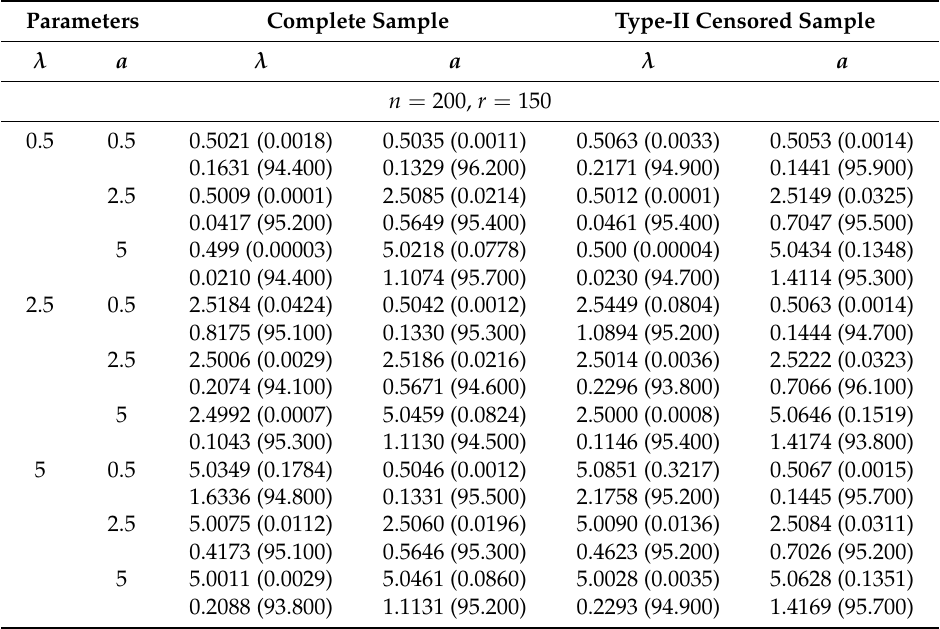
Table 4. The AVs of estimates and corresponding MSEs (in parentheses) in the first row and the CIL and corresponding coverage probability (in parentheses) in the second